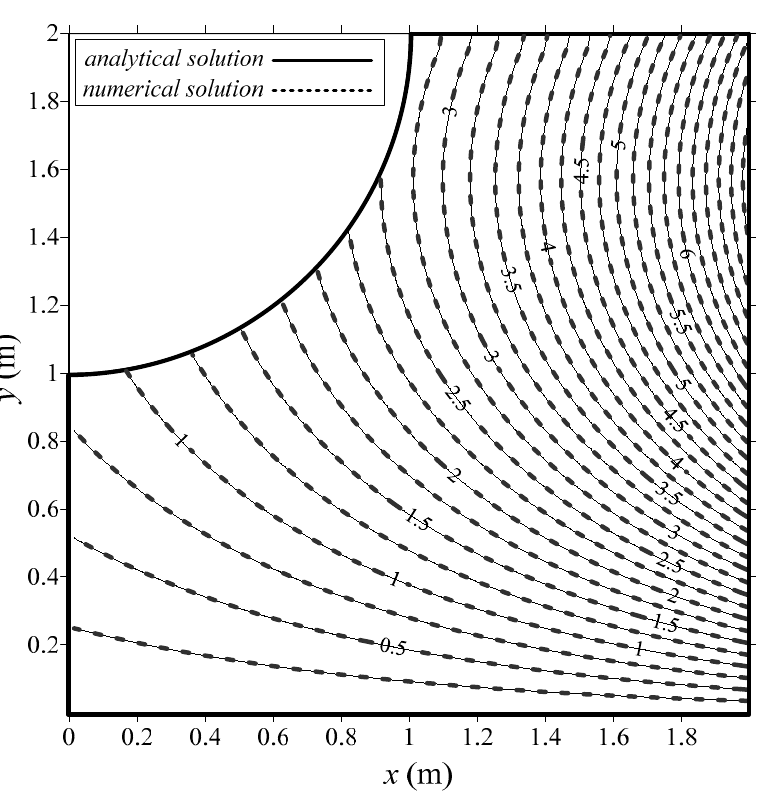
Figure 11. Comparison of temperature distribution with the analytical solution.